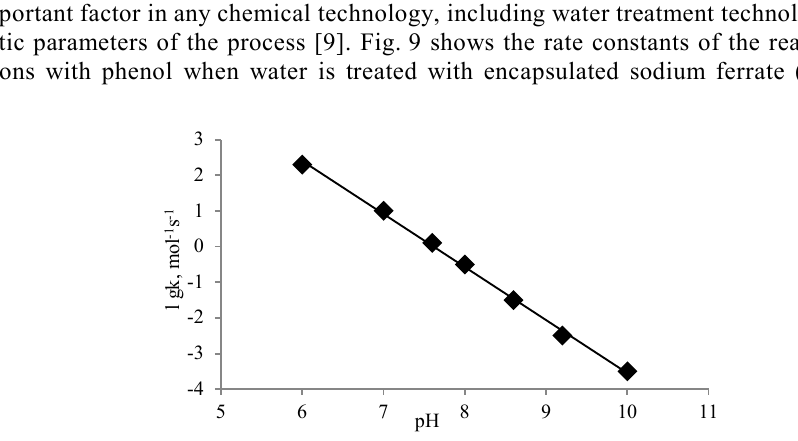
Fig. 9. Dependence of the rate constant of the reaction of encapsulated sodium ferrate with phenol in water on the pH of the